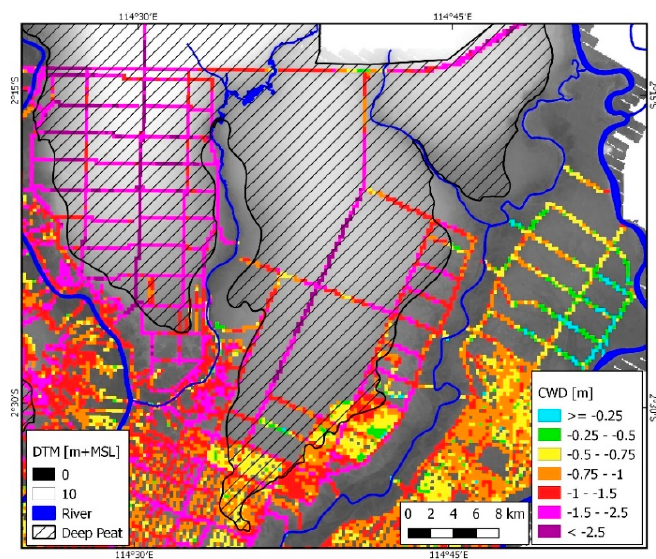
Figure 9. Demonstration of CWD pattern in area B in Figure 7. The white dashed area is deep peatland ( > 3 m [4]). In this area, CWD values on top of peat domes were mostly below − 1.5 m and often below − 2.5 m in the dry season of 2011, whereas values in the low-lying rice scheme canals to the east of the area varied between − 1 and 0 m.